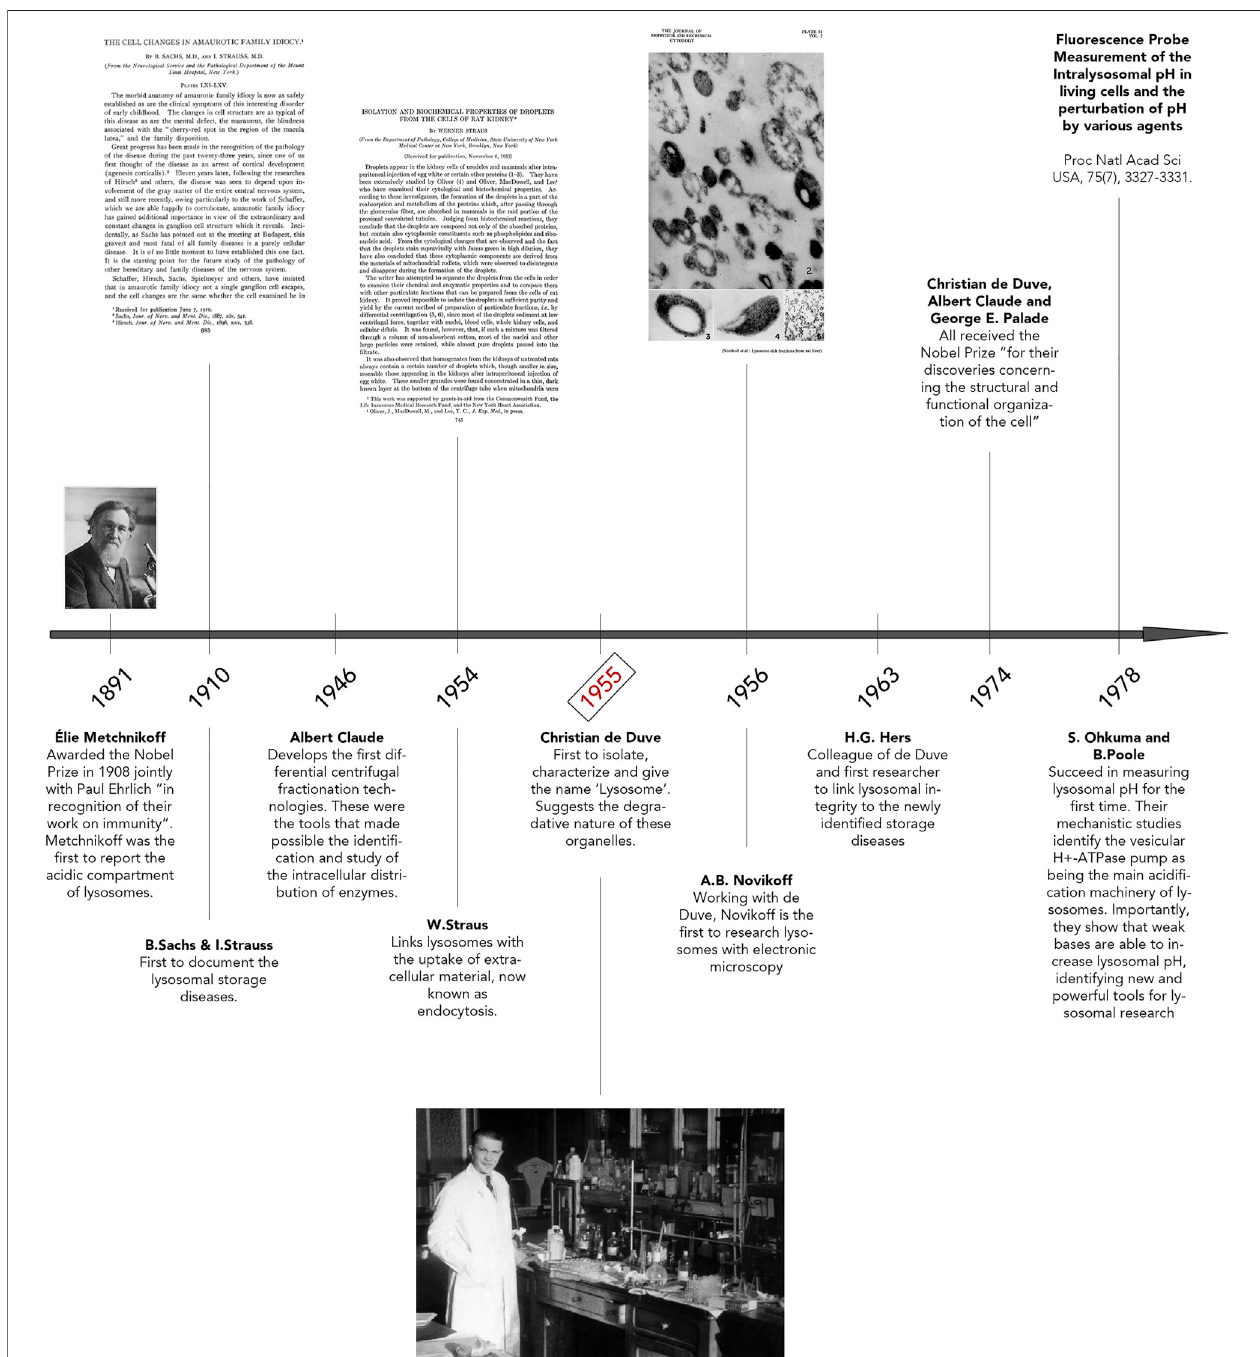
FIGURE 1 | Discovery of Lysosomes. Timeline illustrating key breakthroughs in research that led to lysosomal identi fi cation and discovery. Important pioneers of lysosome research are highlighted here, including Élie Metchnikoff, Albert Claude, and Christian de Duve. The photo of Élie Metchnikoff is reproduced with permission from Mary Evans Picture Library. The title page of “ The Cell Changes in Amaurotic Family Idiocy ” was reproduced with permission from The Rockefeller Institute for Medical Research New York ( © Copyright 1910 Sachs B, Strauss I. Originally published in J Exp Med . 1910; 12(5):685 – 695. https://doi.org/10.1084/jem.12.5. 685).Thetitlepageof “ Isolationandbiochemicalpropertiesofdropletsfromthecellsofratkidney ” wasmadefreelyavailableundertheCreativeCommonsAttribution4.0 International Public License (Strauss w. Originally published in J Biol Chem . 1954; 207(2):745 – 755. https://doi.org/10.1016/S0021-9258(18)65693-5). The photo of Christian de Duve, entitled “ Christian de Duve in his laboratory ” , was reproduced freely from the Digital Commons at Rockefeller University. Plate 61 seen in “ Electron MicroscopyofLysosome-richFractionsfromRat Liver ” wasreproducedwithpermissionfromTheRockefellerInstitute forMedicalResearch( © Copyright1956Novikoff AB, Beaufay H and deDuve C. Originally published in The Journal of biophysical and biochemical cytology , 2 (4 Suppl), 179 – 184.